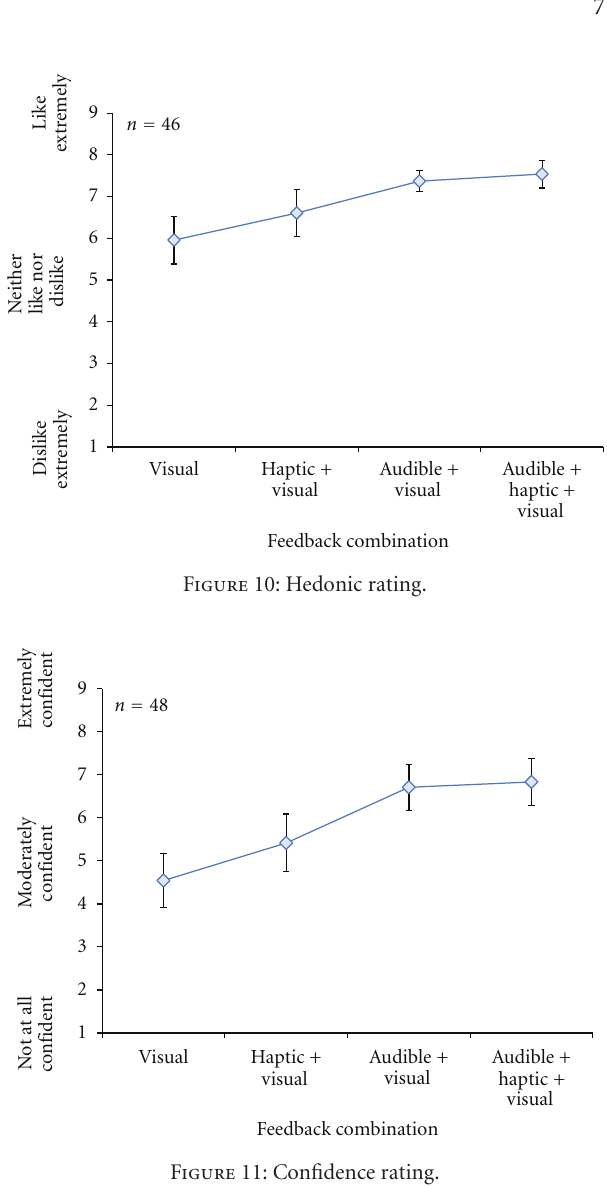
Figure 11: Confidence